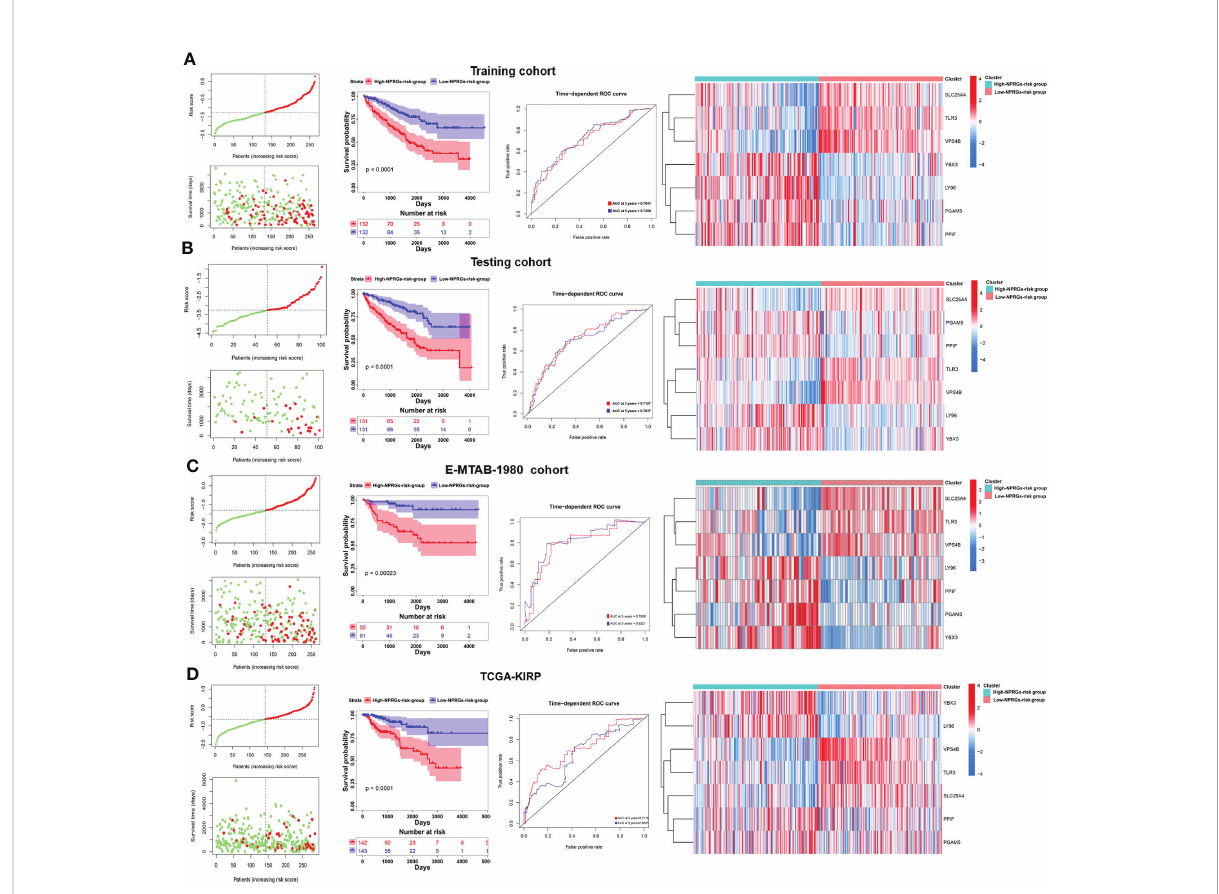
FIGURE 3 Prognostic analyses of NPRGs risk signature in TCGA-KIRC training cohort, TCGA-KIRC testing cohort, E-MTAB-1980 cohort, and TCGA-KIRP cohort. (A) Distribution of OS, OS status, and risk score in the TCGA-KIRC training cohort; the Kaplan – Meier curves of the high- or low-NPRGs- risk cohort in TCGA-KIRC training cohort; AUC of time-dependent ROC curves was used to evaluate the prognostic performance of the NPRGs risk score; the heatmap of the expression of NPRGss in high- or low-NPRGs-risk groups. (B – D) The same analyses in the TCGA-KIRC testing cohort, E-MTAB-1980 cohort, and TCGA-KIRP